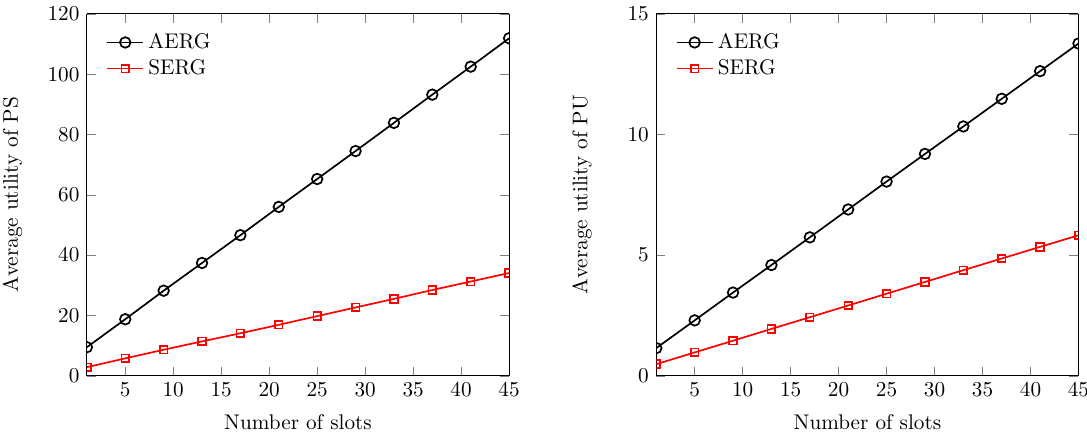
( b ) Utility of each PU vs. number of slots. Figure 9.